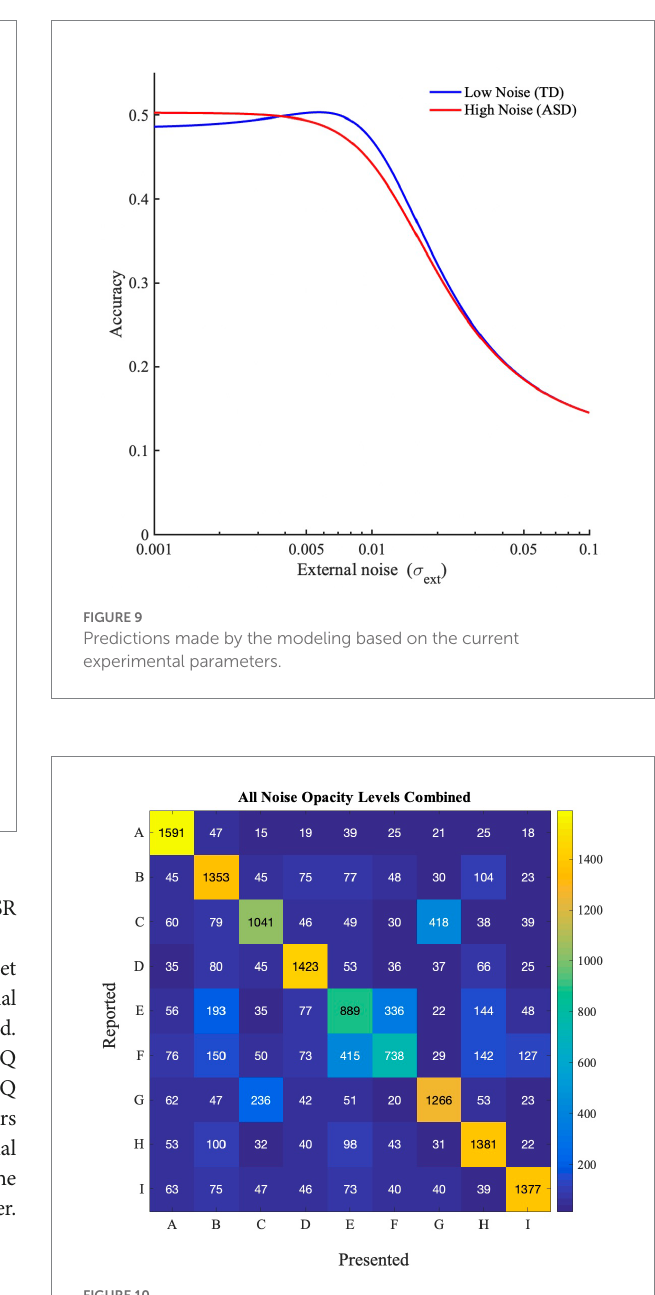
FIGURE 10 Confusion matrix depicting how accurately the letters in the online experiment were correctly guessed across all noise opacity levels in Experiment 2.